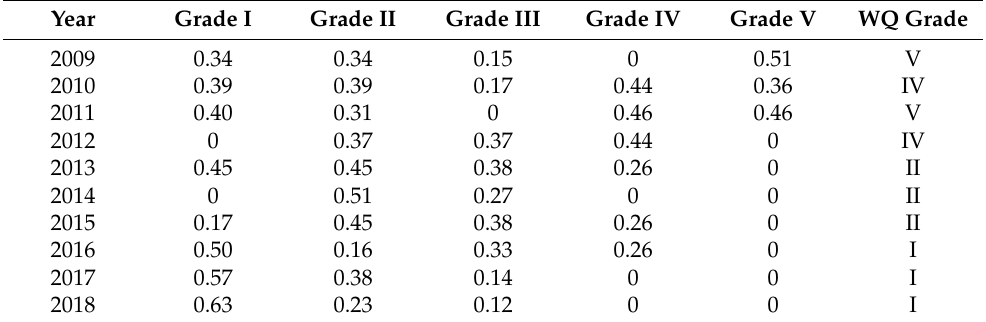
Table A14. Fuzzy integrated evaluation results of Jishuigang Station in Qingpu,